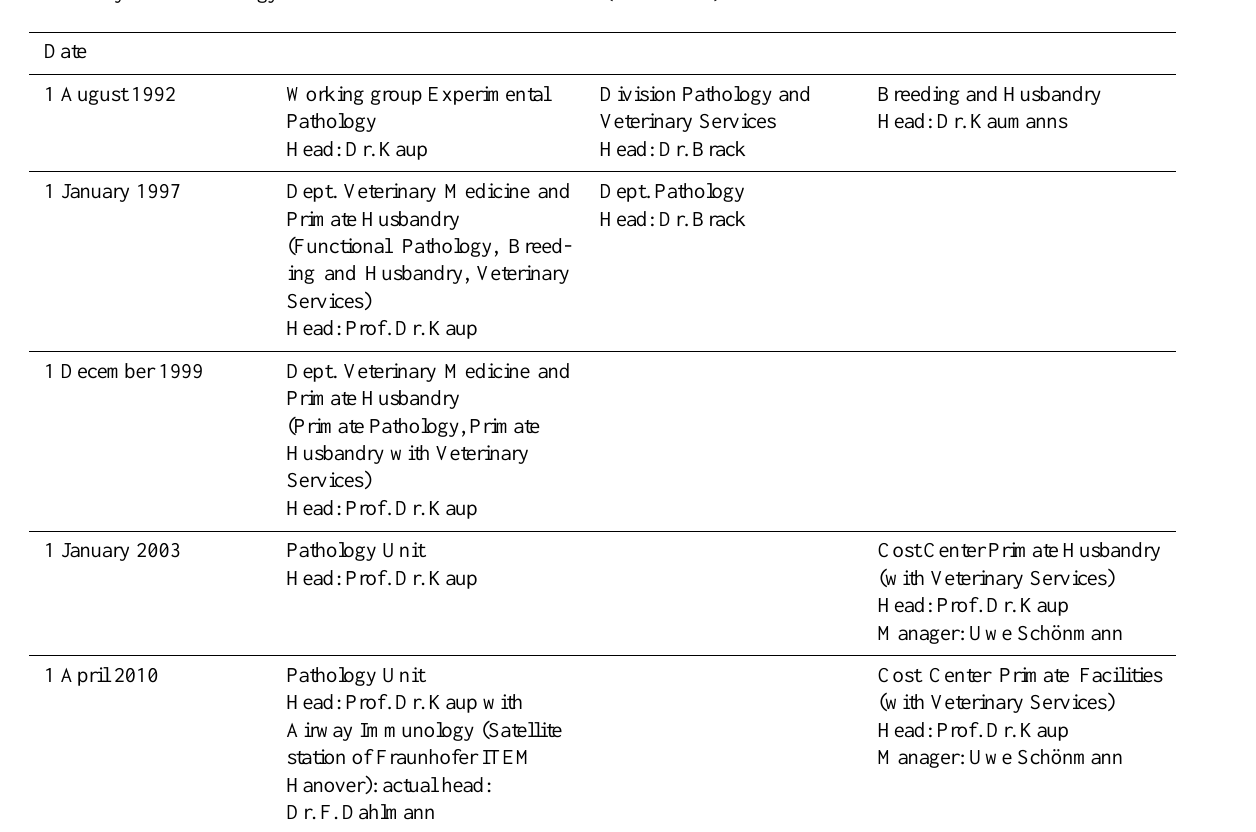
Table 1. History of the Pathology Unit at the German Primate Center